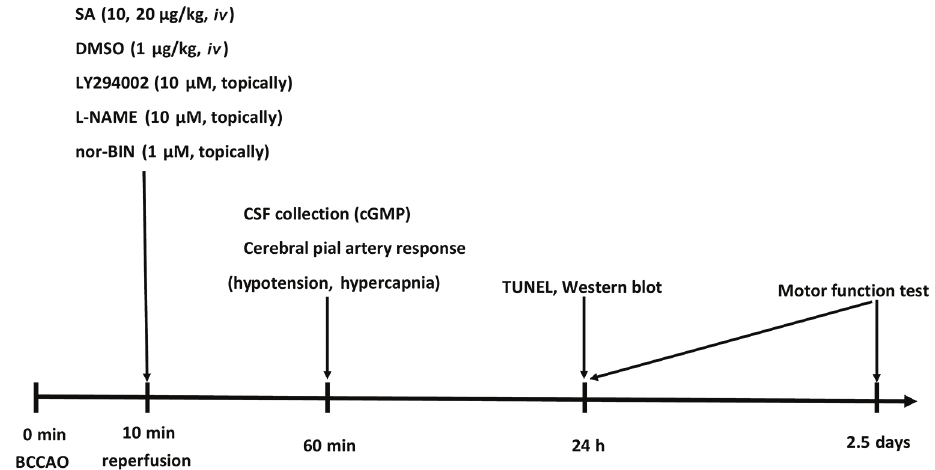
Figure 1. Protocol fl owchart. The bilateral common carotid arteries were colligated for 10 min to establish forebrain ischemia followed by reperfusion. SA: salvinorin A; DMSO: dimethyl sulfoxide; nor-BIN: norbinaltorphimine; BCCAO: bilateral common carotid artery occlusion; CSF: cerebrospinal fl